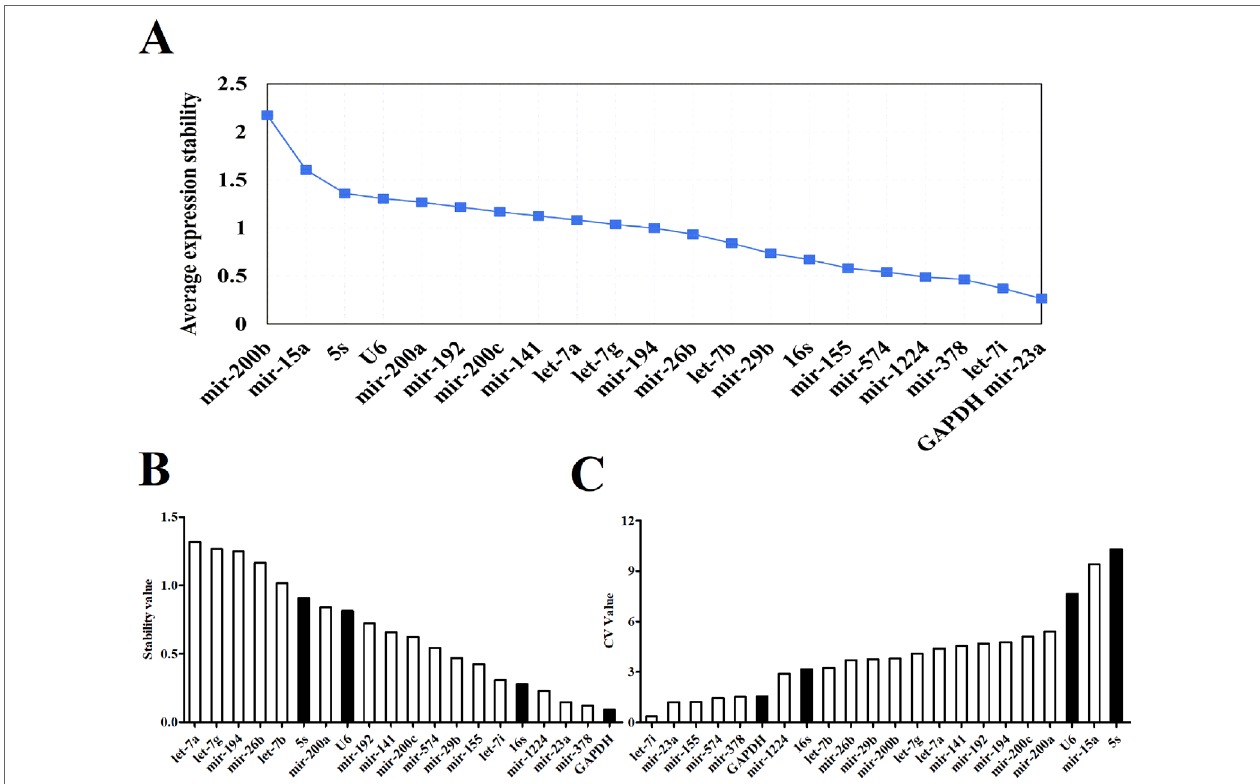
FIGURE 3 | The expression stabilities of candidate reference genes analyzed by software. (A) Average expression M values analysis of candidate reference genes by geNorm software. (B) Average expression stability values analysis of candidate reference genes by NormFinder software. (C) Average expression CV values analysis of candidate reference genes by Bestkeeper